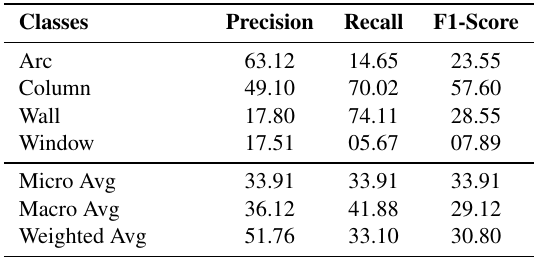
Table 3. Precision, Recall and F1-score for each